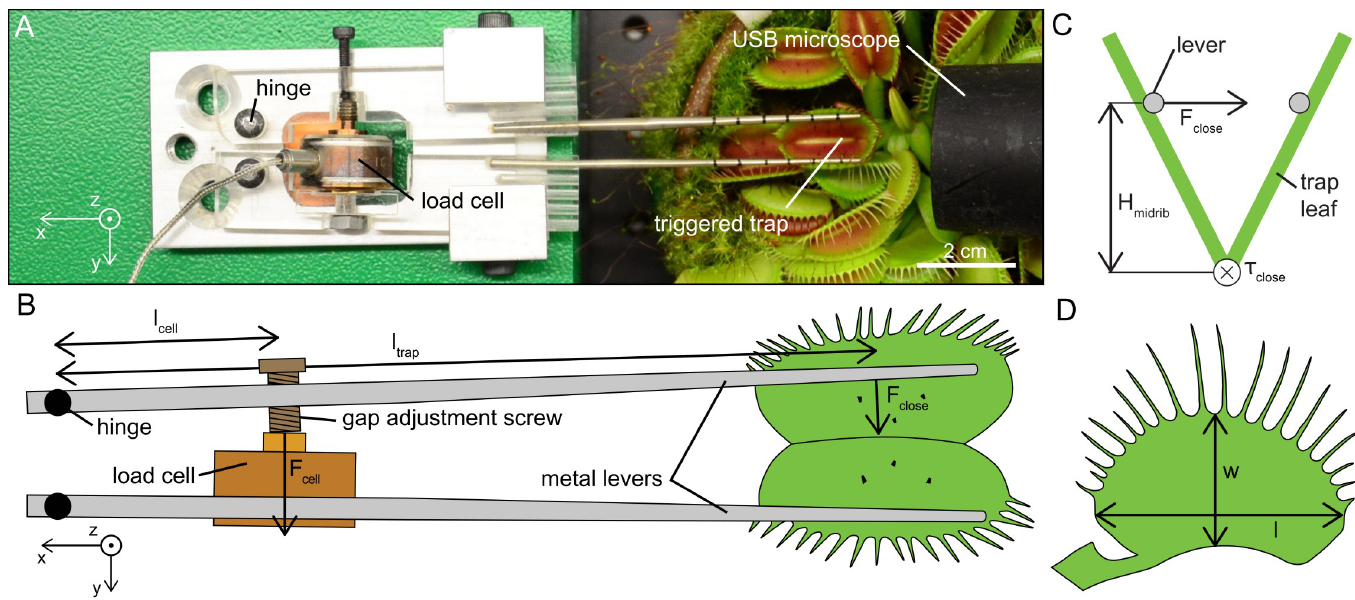
Fig 7. Snap force sensor setup. (A) Top view of the snap force sensor with a triggered trap. (B) Schematic top view of the snap force sensor showing how the force generated by the flytrap is transmitted onto the load cell. (C) Relation between measured force F close , the height of the levers, and the closing torque τ close . (D) Schematic of the measured geometries, i.e., width w and length l of a